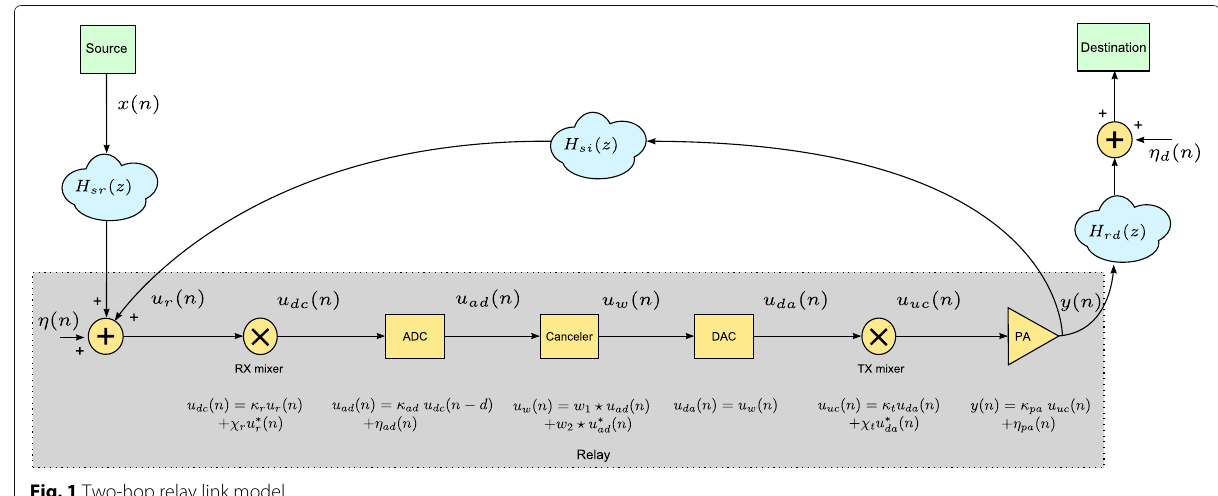
Fig. 1 Two-hop relay link model